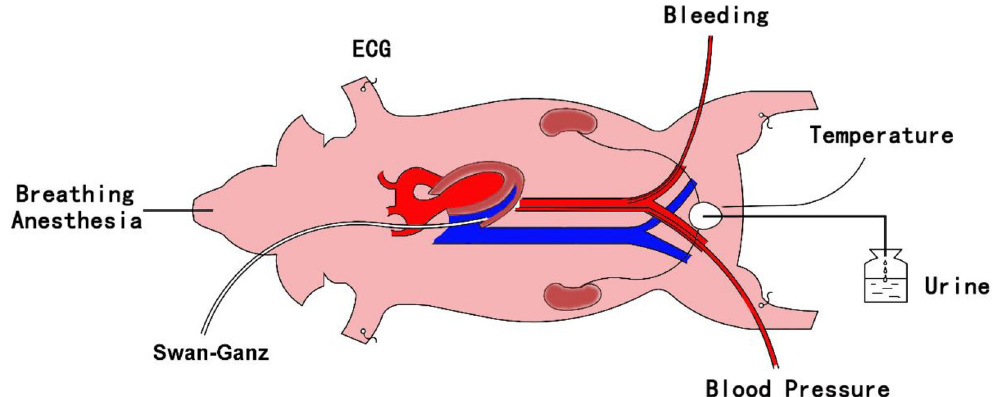
Fig 1. Schematic diagram of the model. ECG, electrocardiogram; MAP, mean arterial pressure.